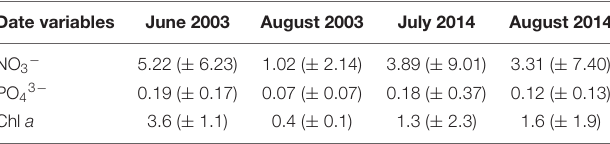
TABLE 1 | Mean ( ± SD) concentrations of nitrate (NO 3 − ; µ M), phosphate (PO 43 − ; µ M), and chlorophyll a (Chl a ; mg Chl m − 3 ) of surface water over entire East China Sea in different sampling periods.